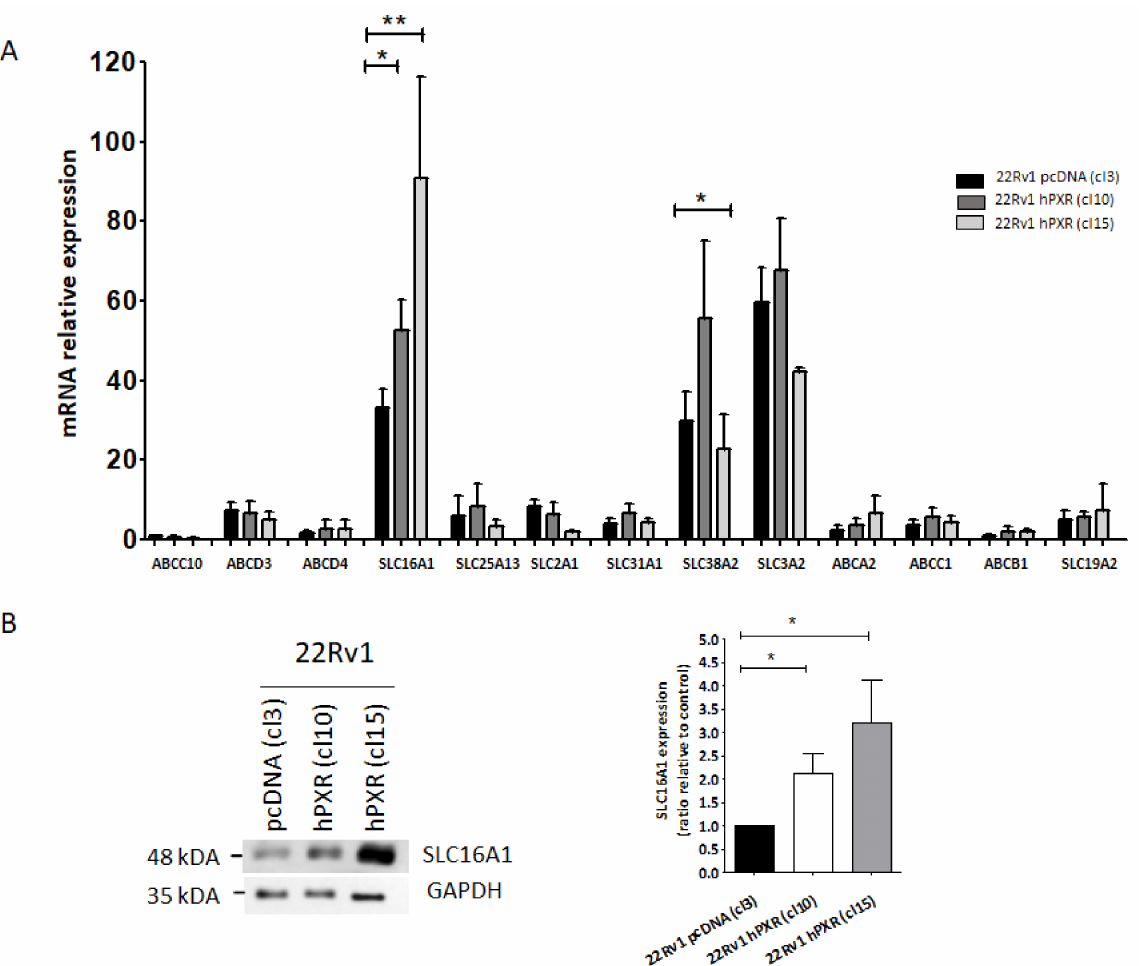
Figure 5. Effects of PXR on the expression of drug transporters. ( A ) Comparison of the expression levels of a set of 13 genes that were identified using the RT 2 Profiler™ PCR Array Human Drug Transporters from Qiagen between 22Rv1 clones 10 and 15 stably expressing PXR and control clone (clone 3) as measured by RT-qPCR. Gene expression was normalized to the expression of HPRT and plotted relative to the expression of the ABCC10 gene expression in the control clone (set at 1). Results are the mean ± SEM of at least three independent experiments. ( B ) Immunoblot analysis of SLC16A1 expression in control clone and clones 10 and 15. GAPDH was used as a loading control and quantification was performed using the Image J software. Results are plotted as ratios of SLC16A1 expression relative to control clone and are the mean ± SEM of three independent blots. Statistical analyses were carried out using Student’s t -test and considered statistically significant for p < 0.05 (*) or p < 0.001 (**),